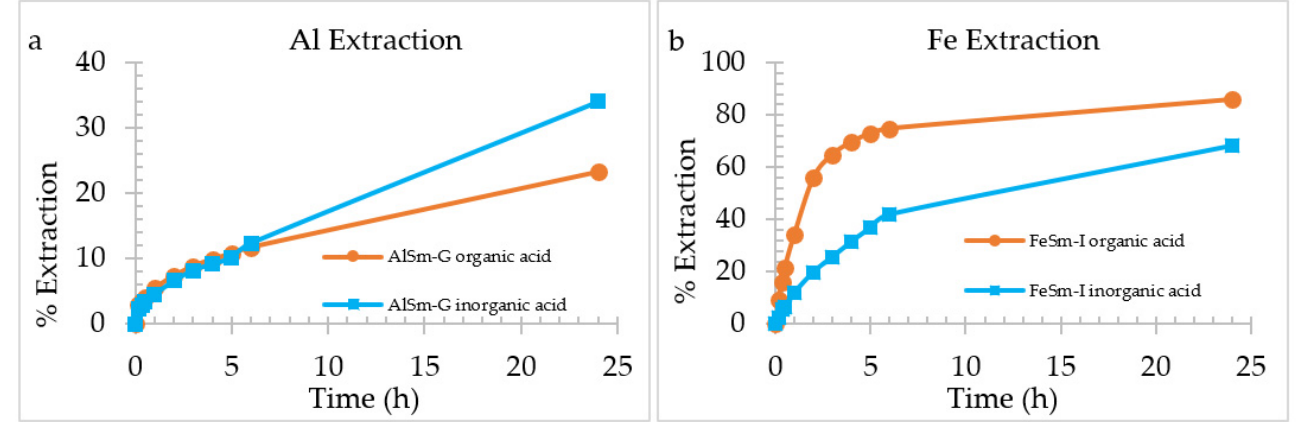
Figure 5. ( a ) Extraction of aluminium versus time for AlSm-G smectite and ( b ) extraction of iron versus time for FeSm-I smectite, in oxalic and sulphuric acid (80 °C; acid concentration 1 M; 2% pulp density).